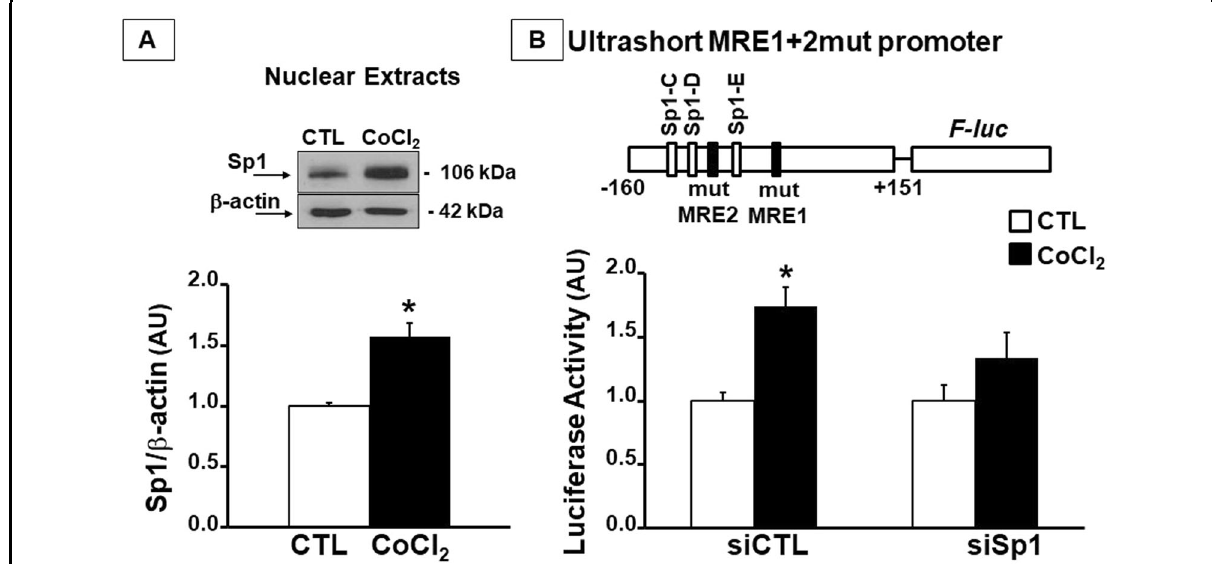
Fig. 3 Sp1 was able to modulate the Na + /Ca 2 + exchanger brain Slc8a1 promoter following CoCl 2 treatment. A Representative Western blot of Sp1 in a nuclear extract from SH-SY5Y cells treated with CoCl 2 . B Luciferase assay of SH-SY5Y cells co-transfected with the ultrashort MRE1 + 2mut promoter and non-targeting siRNA (siCTL) or siRNA for Sp1 (siSp1), untreated (CTL) or treated with 100 μ M of CoCl 2 for 24 h. * p < 0.05 vs. CTL by t -test for panel A . * p < 0.05 vs. CTL by one-way ANOVA followed by Bonferroni test for panel B . Each column represents the mean ± SEM of 6 independent experimental sessions, each one run in